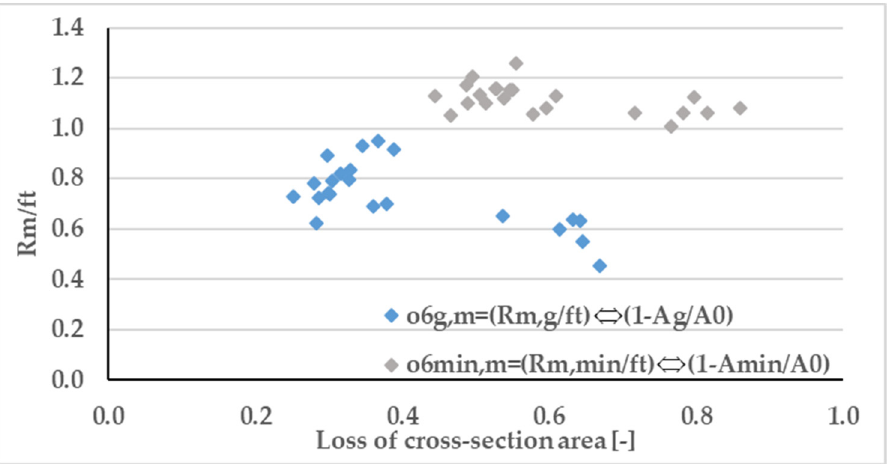
Figure 8. Dependence of the tensile strength ratio of the corroded to non-corroded samples (R m,g /f t ) and (R m,min /f t ) on the relevant loss of cross-sectional area of reinforcement ϕ 6 ((1 − A g /A 0 ) or (1 − A min /A 0 )).